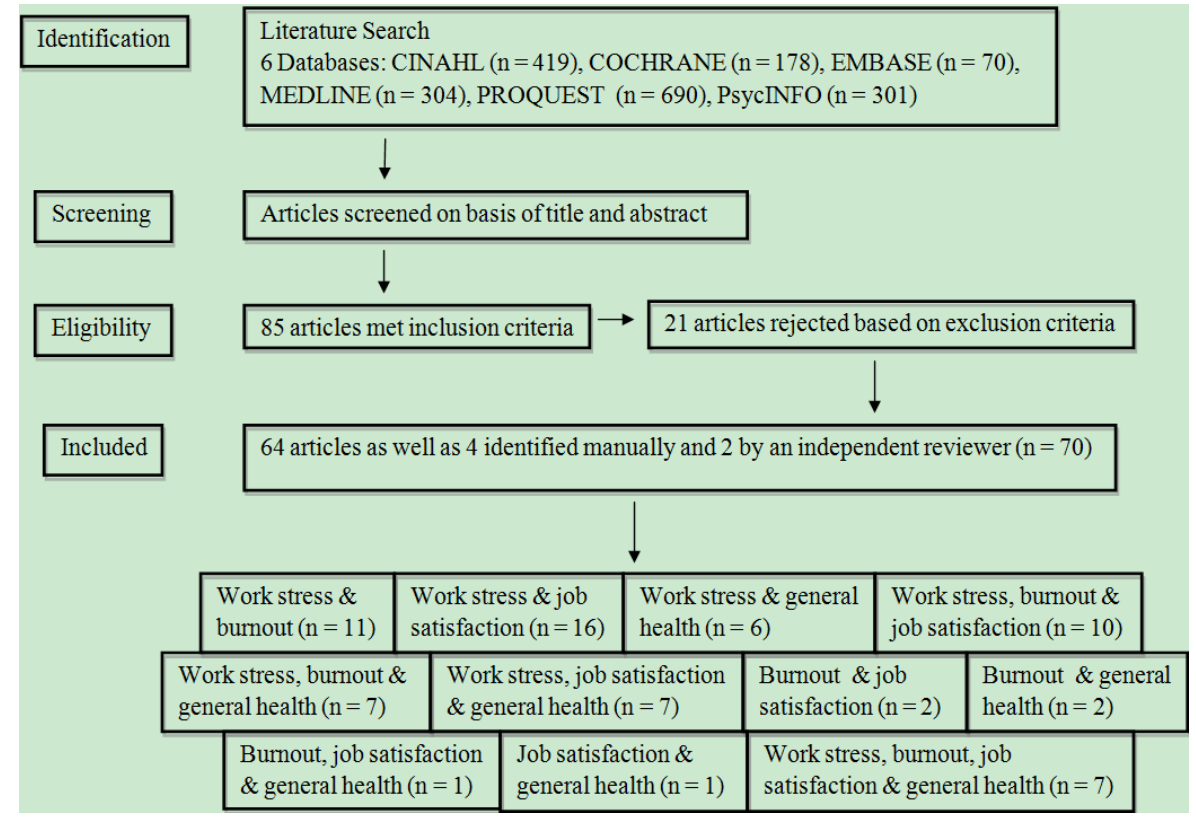
Figure 2. A flow chart describing selection of articles using inclusion and exclusion